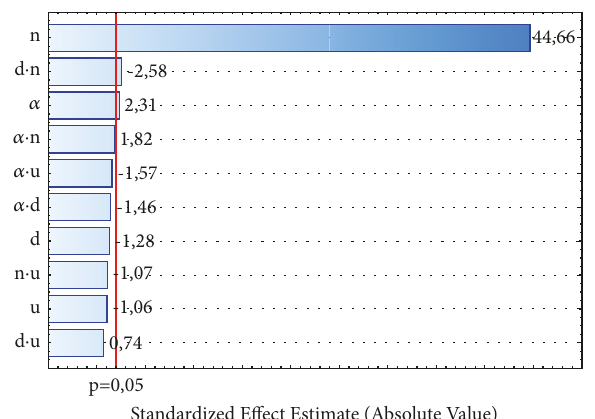
Figure 6: Pareto chart of standardised effects of the regression model of the polymer pressure